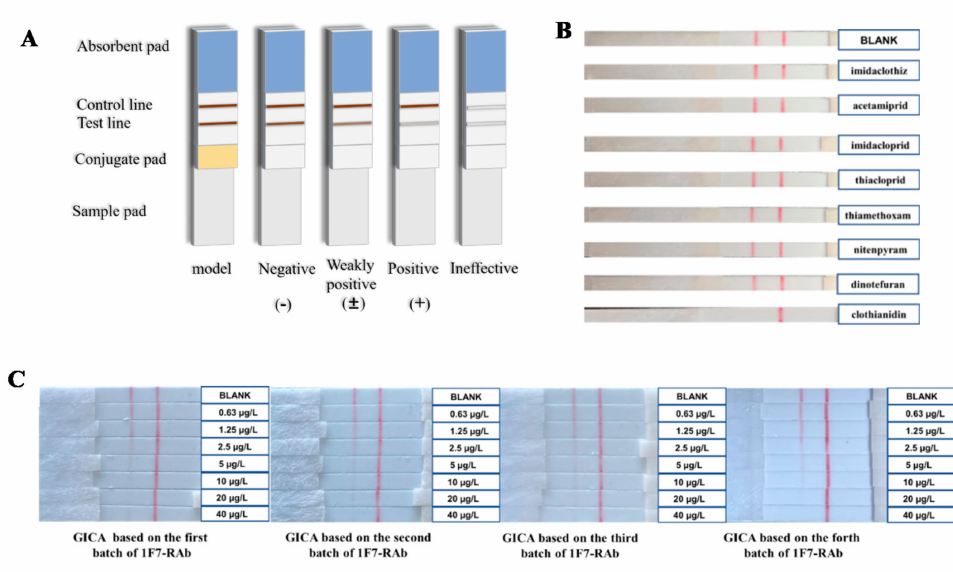
Figure 4. Tests using GICA. ( A ) Schematic diagram and the results of GICA. ( B ) Cross-reaction test of 1F7-RAb-based GICA to clothianidin and 7 analogues at 1000 µ g/L. ( C ) Four batches of GICA tests for the standard solutions of clothianidin at 0, 0.63, 1.25, 2.5 5, 10, 20, and 40 µ